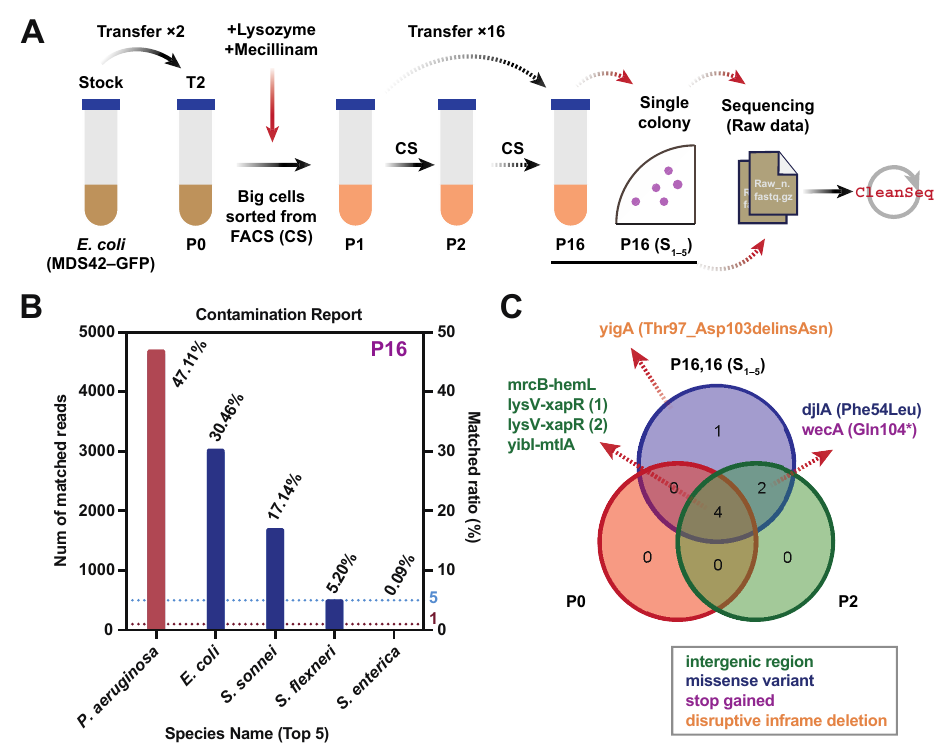
Figure 5. Performance of CleanSeq on a real experimental dataset. ( A ) The schematic representation of a laboratory experimental evolution in E. coli . Following the addition of cell wall-targeting reagents in culture media, Mecillinam, and lysozyme, bigger cells sorted from FACS (CS) were used for subsequential passages. The strategy of the CS-passage cycle was repeated 16 rounds for laboratory experimental evolution. The indicated strains and single colonies (P16 and P16S 1–5 ) were subjected to WGS. The results from CleanSeq were plotted, showing the taxonomic classification of all reads in ( B ) and seven genome variants in both P16 and P16S 1–5 were found and verified, as summarized in a Venn diagram ( C ).